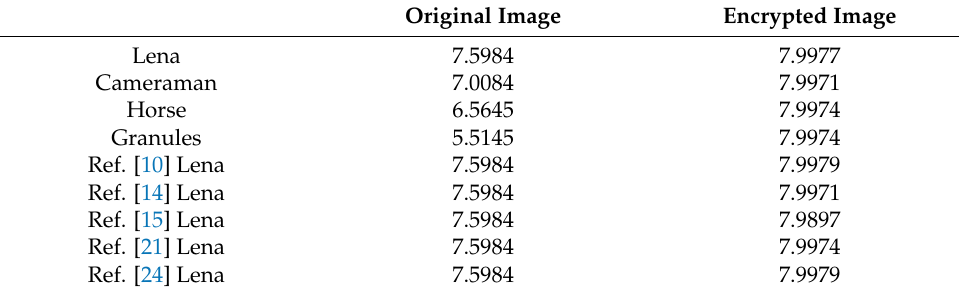
Table 3. Information entropy